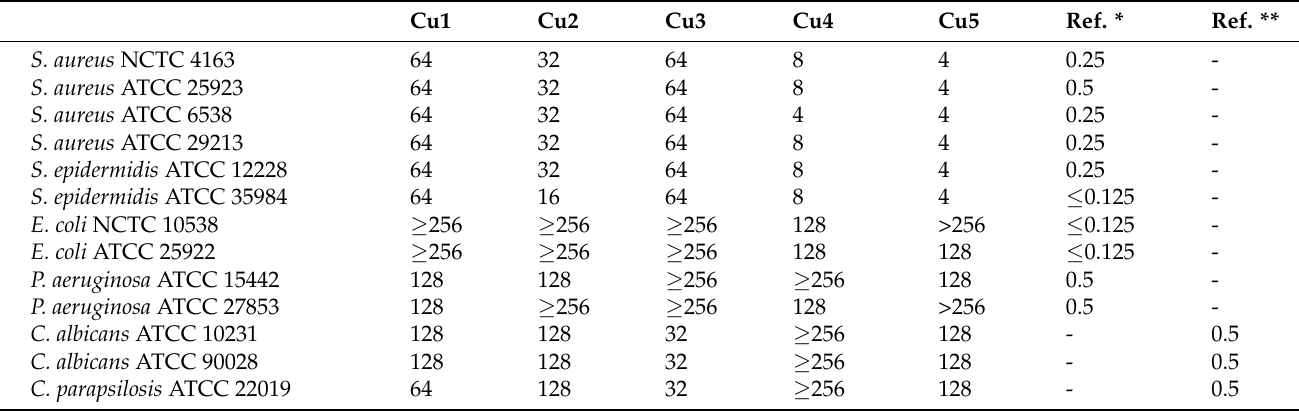
Table 4. In vitro activity of thiourea complexes Cu1 – Cu5 against standard bacterial and fungal